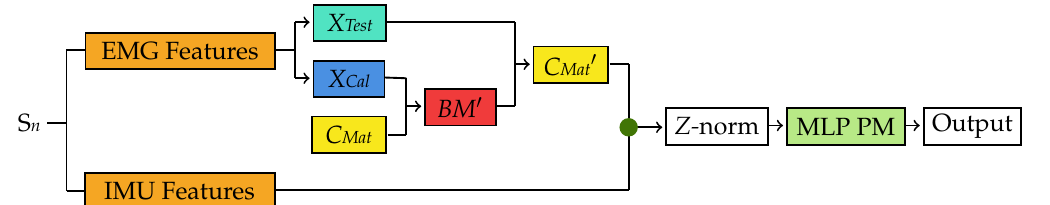
Figure 7. Testing flow for the Bilinear Model-based classification method during each cross-validation iteration using both EMG and IMU data. A similar procedure was used for the EMG only dataset. EMG data from Subject S n in the cross-validation testing fold (orange) are split into X Cal and X Test . Then, a new bilinear EMG model BM (cid:48) (red) specific to Subject S n is created based on X Cal and the motion-dependent factors extracted in Figure 6 [9]. This new bilinear model is used to estimate a new set of motion-dependent factors C Mat (cid:48) based on X Test (aqua) from Subject S n . These motion-dependent factors are then classified using the MLP predictive model created in Figure 6. The green dots represent a feature-level